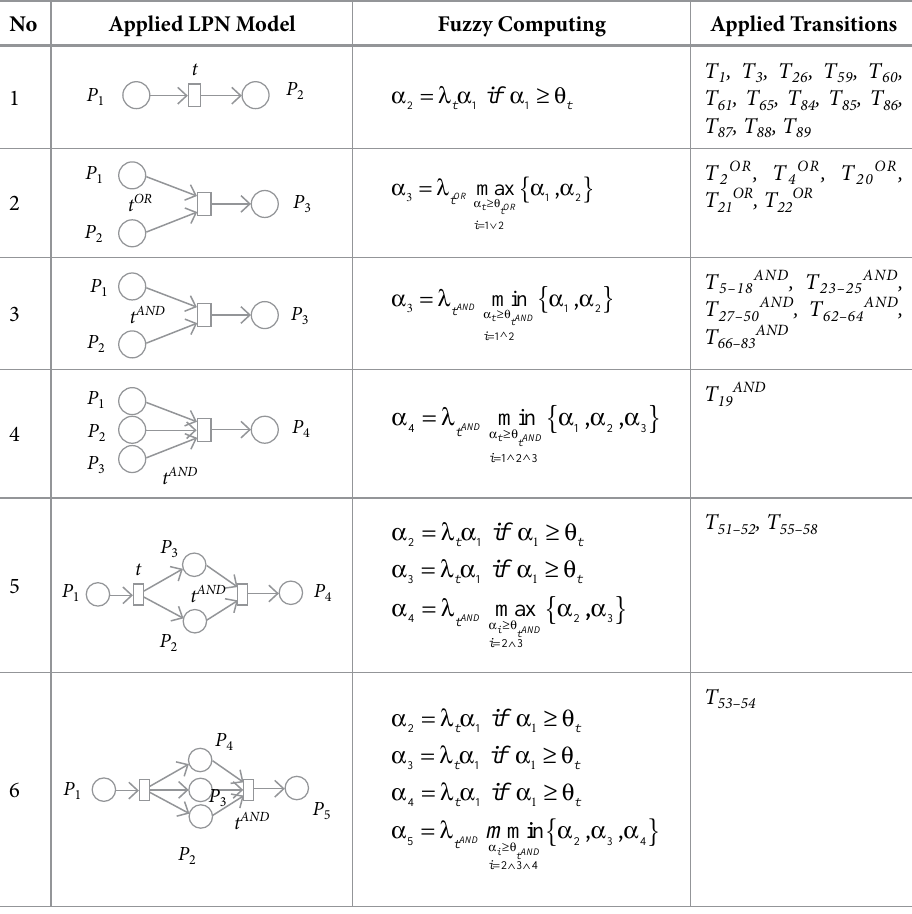
Table 1. Models of logical Petri nets (applied to transforming 89 fuzzy inference rules for designing the support information system in bio-robots) No Applied LPN Model Fuzzy Computing Applied Transitions